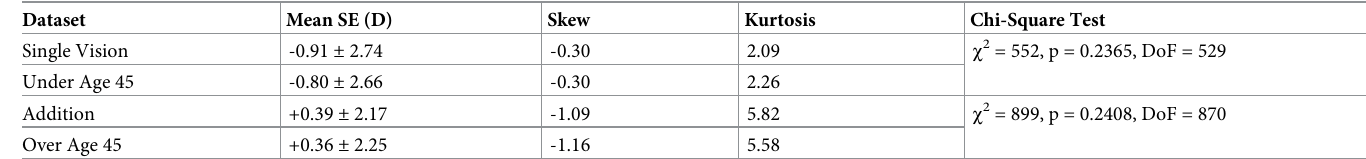
Table 3. Descriptive statistics comparing single vision EMR prescriptions to younger EMR patients and addition EMR prescriptions to older EMR patients.